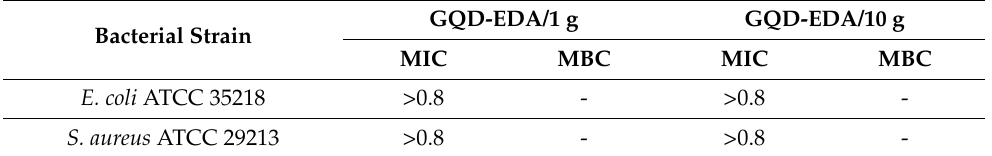
Table 4. Minimum inhibitory concentrations of GQD-EDA/1 g and GQDs-EDA/10 g (in mg mL − 1 ).